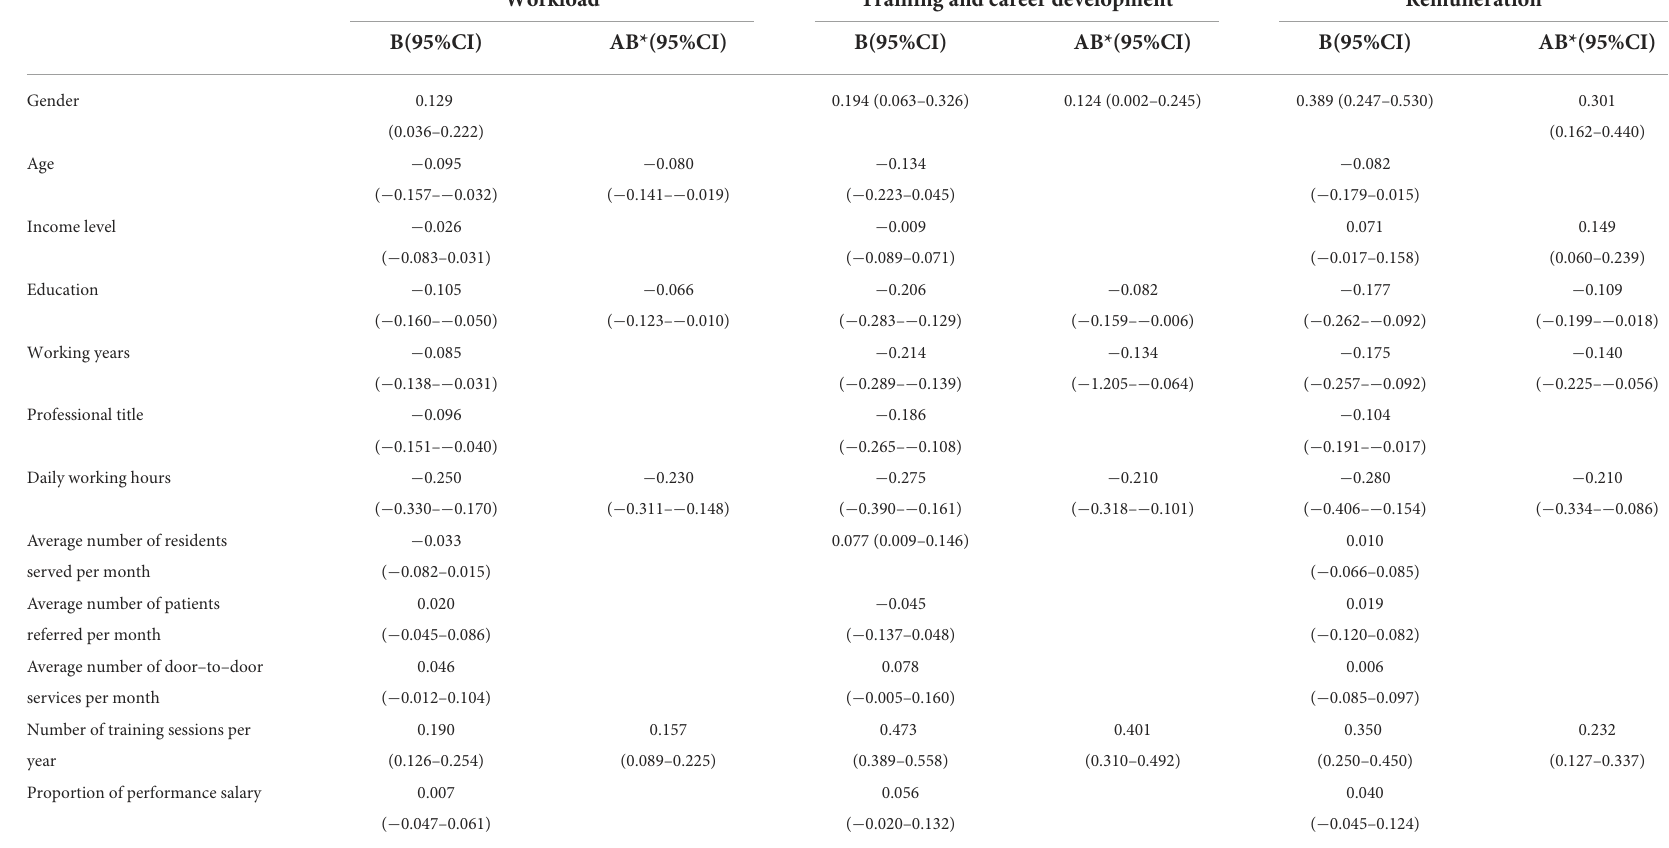
TABLE 3 Multi–factor analysis of FPTMs’ job